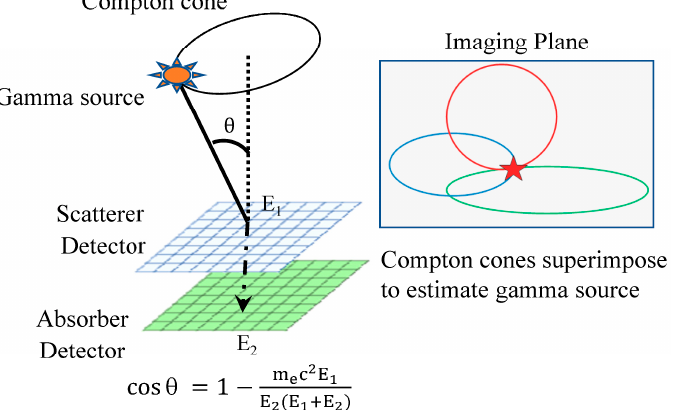
Figure 2. Schematic illustration of a general Compton camera ( left ); Compton cones of each event are superimposed to locate the γ -ray source ( right ).